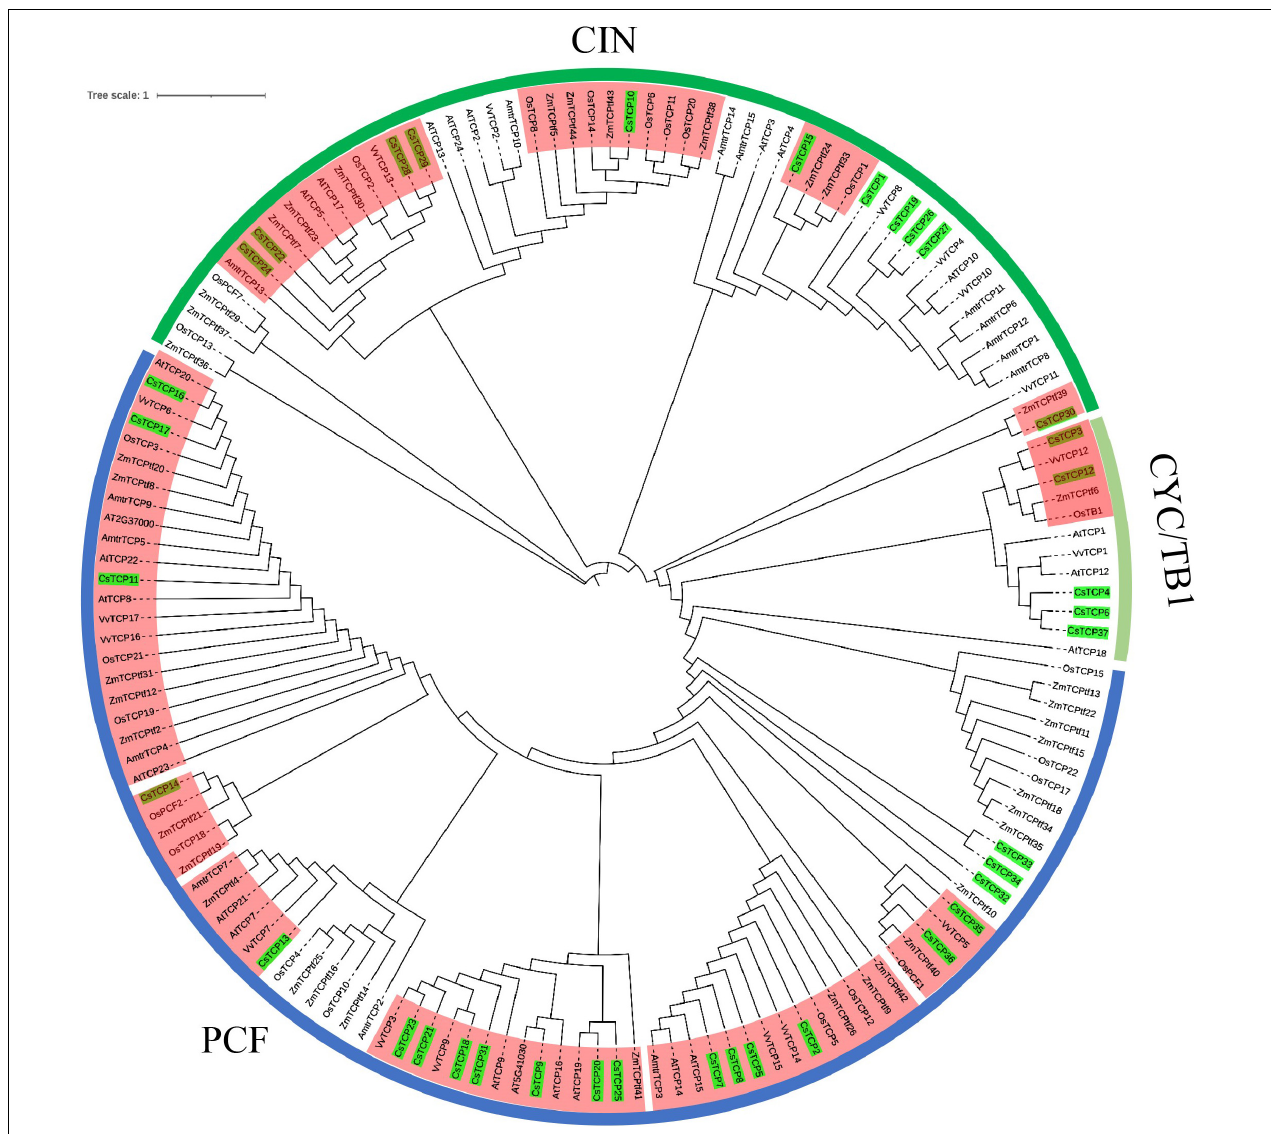
FIGURE 4 | The phylogenetic analysis of TCP gene family among Camellia sinensis, Arabidopsis thaliana , Oryza sativa, Zea mays, Vitis vinifera, and Antirrhinum majus . The red shaded part is the clades containing both monocots and eudicots TCP